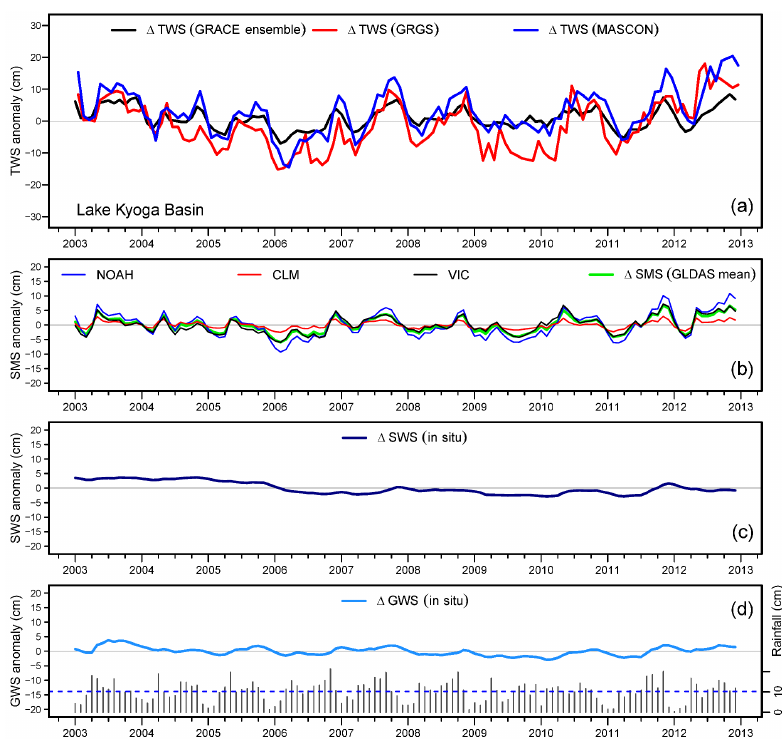
Figure 6. Monthly time-series datasets for the Lake Kyoga Basin (LKB) from January 2003 to December 2012: (a) GRCTellus GRACE- derived (cid:49) TWS (ensemble mean of CSR, GFZ, and JPL), GRGS, and JPL-Mascons (cid:49) TWS time-series data; (b) GLDAS-derived (cid:49) SMS (individual signals as well as an ensemble mean of NOAH, CLM, and VIC); (c) lake-level-derived (cid:49) SWS; and (d) borehole-derived (cid:49) GWS time-series data. Note that monthly rainfall records derived from the TRMM satellite are plotted in panel (d) where the dashed horizontal line represents the mean monthly rainfall for the period of January 2003 to December 2012.